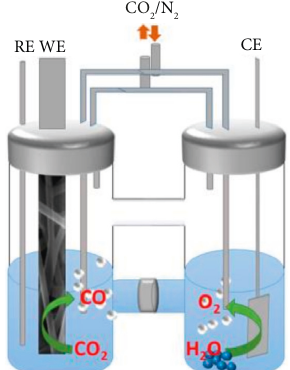
Figure 9: Experimental setup for electrochemical studies during CO 2 and N 2 purging in a standard three-electrode arrangement in H-Cell with gas inlet and outlet. Nanofibrous Co 3 O 4 acts as a WE, Pt as a CE, and Ag/AgCl as a QRE in a 0.1M TBAPF 6 in acetonitrile with 1 vol% H 2 O from [72] under the terms of the Creative Commons CC BY